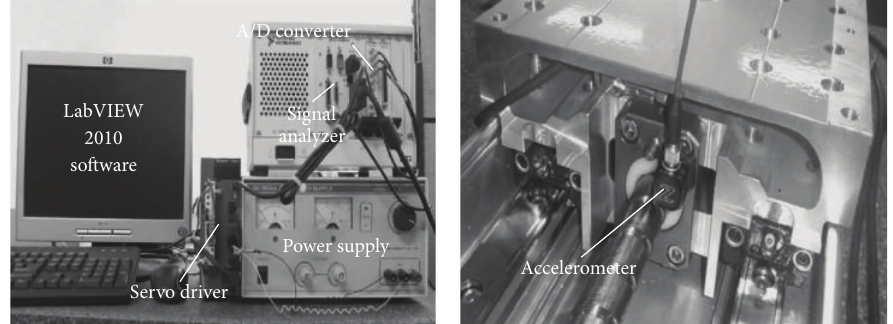
Figure 6: Condition monitoring system with data acquisition, sensor, and analyzing S/W.